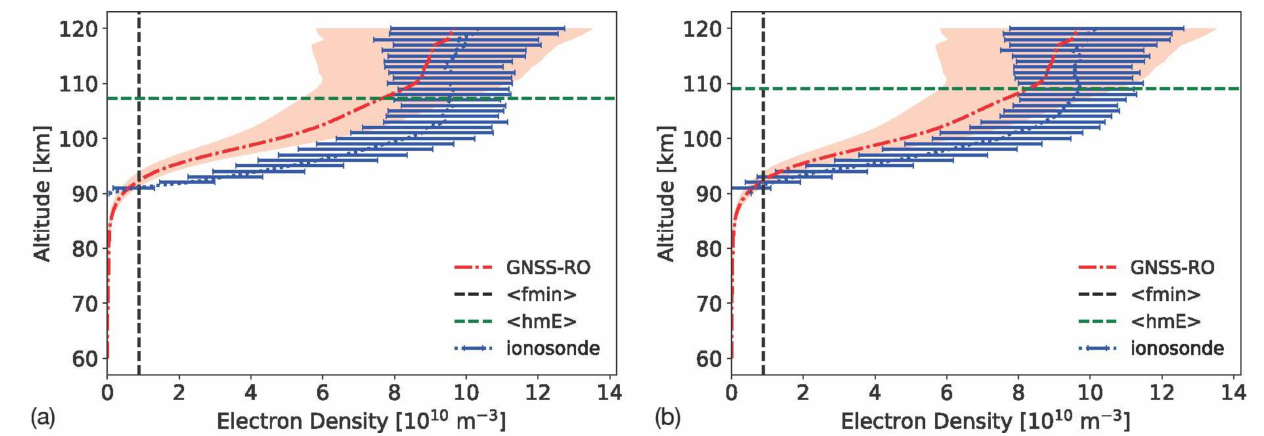
Figure 17. Average daytime (LST = 0800–1600) N e for the GPS-RO and ionosonde techniques for ( a ) unshifted and ( b ) shifted profiles. The average f min is displayed as a vertical line, while the average h m E is displayed as a horizontal